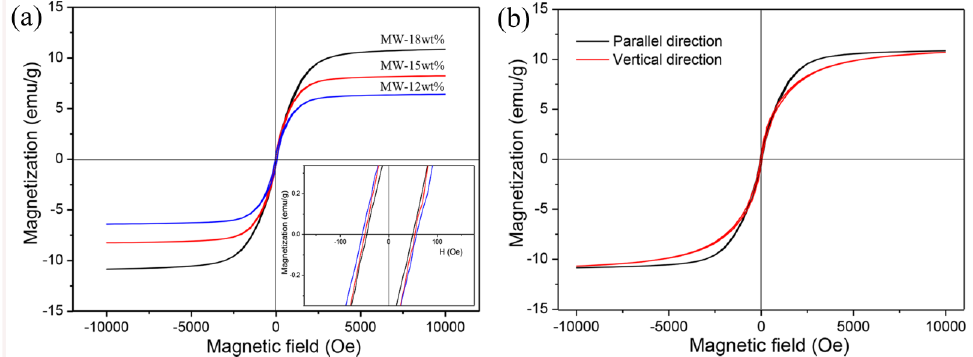
Figure 7. Magnetization curves of modified wood composites. ( a ) MW–12 wt %, MW–15 wt % and MW–18 wt %. ( b ) MW–18 wt % at parallel and vertical direction.